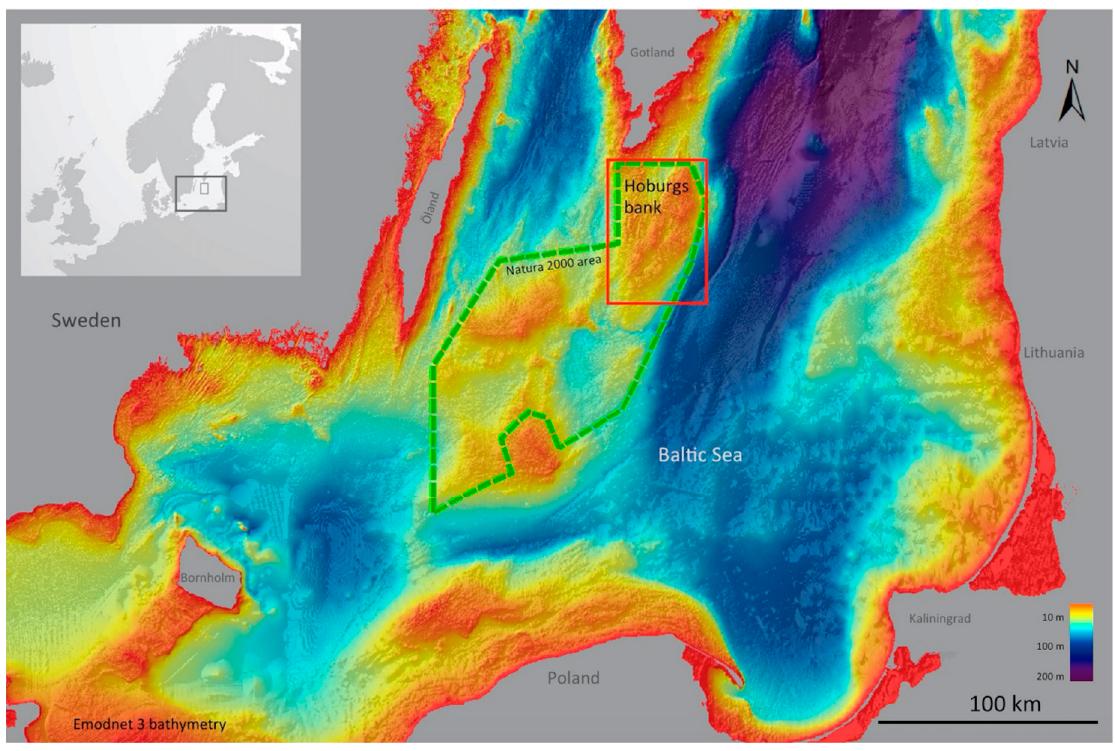
Geosciences 2019 , 9 , x FOR PEER REVIEW Figure 1. Map of the Hoburgs Bank study area. Figure 1. Map of the Hoburgs Bank study area.